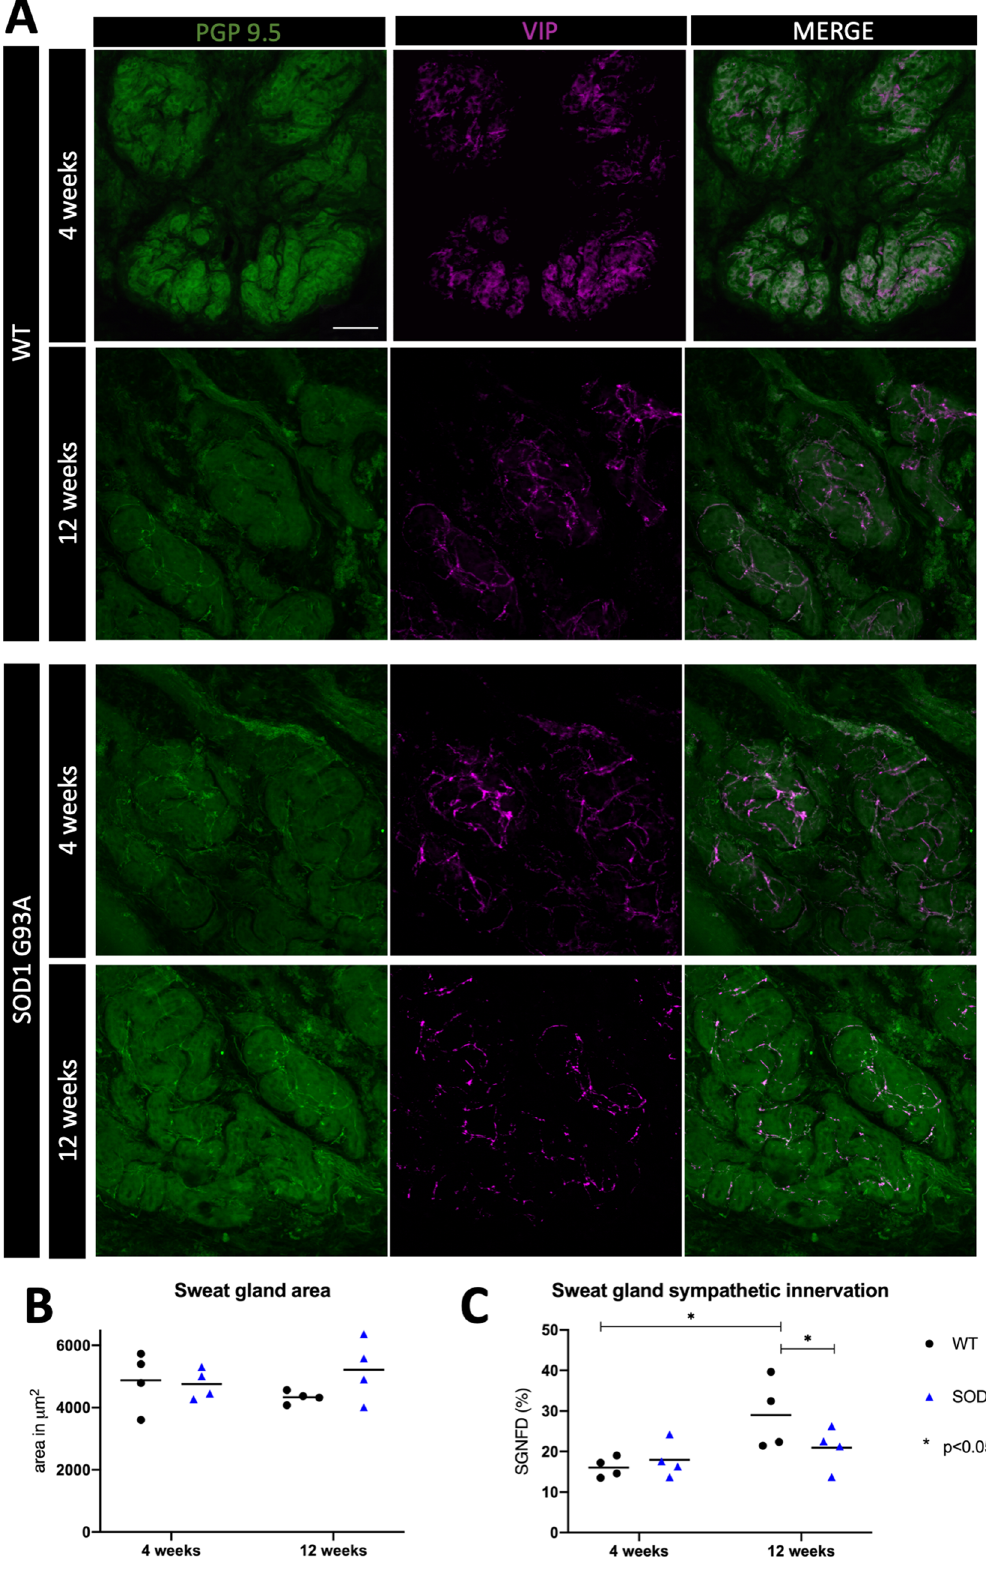
Figure 2. Sweat gland nerve fiber innervation is decreased in the SOD1 G93A mice. ( A ) Representative microphotographs of sweat gland innervation, labele for PGP9.5 and for VIP in SOD1 G93A and WT mice at 4 and 12 weeks. Immunofluorescence colours have been adapted to the colour-blind. ( B ) The mean sweat gland area remained stable overtime in both SOD1 G93A and WT mice. ( C ) SGNF density was similar in SOD1 G93A and WT mice at 4 weeks of age, but at 12 weeks, it was significantly lower in the SOD1 G93A mice. Scale bar: 50 μm. 4 mice WT (black dots) and 4 mice SOD1 G93A (blue triangles) were used in each group. Differences were assessed by two- way ANOVA with post hoc analysis. *p < 0.05. SGNFD sweat gland nerve fiber